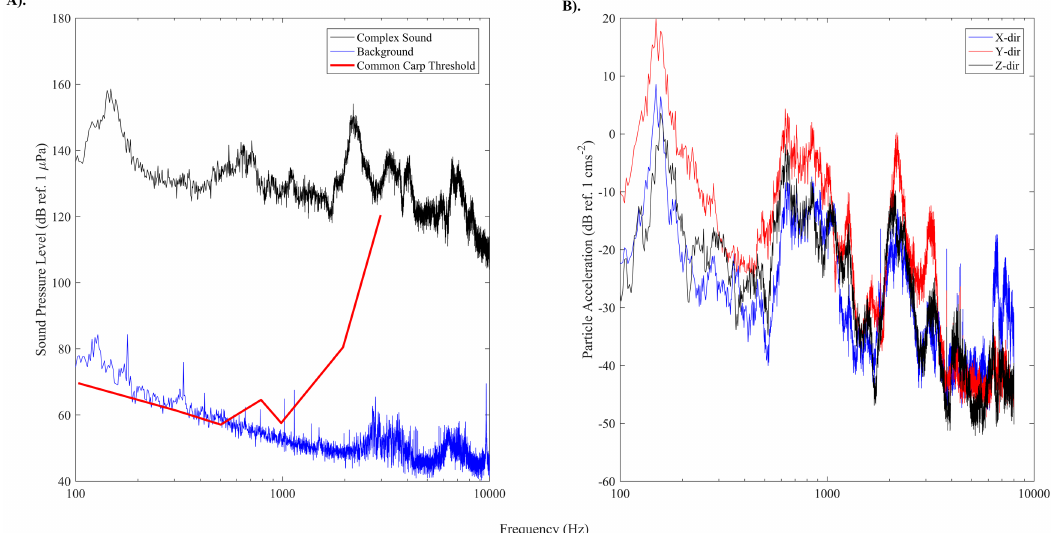
Fig 2. A) Sound pressure level power spectrum of the background noise, playback signal 5 cm from the speaker, and hearing threshold of common carp (from Popper, 1972). B) Particle acceleration measurement in decibels (ref. 1 cms -2 ) in each direction at a point 5 cm in front of the speaker. Sound pressurelevel and particleacceleration measurements are providedat 1 Hz bandwidth.Note, the 1 cms -2 limit suggestedby Knudsenet al. [42] is at 0 dB (ref. 1 cms -2